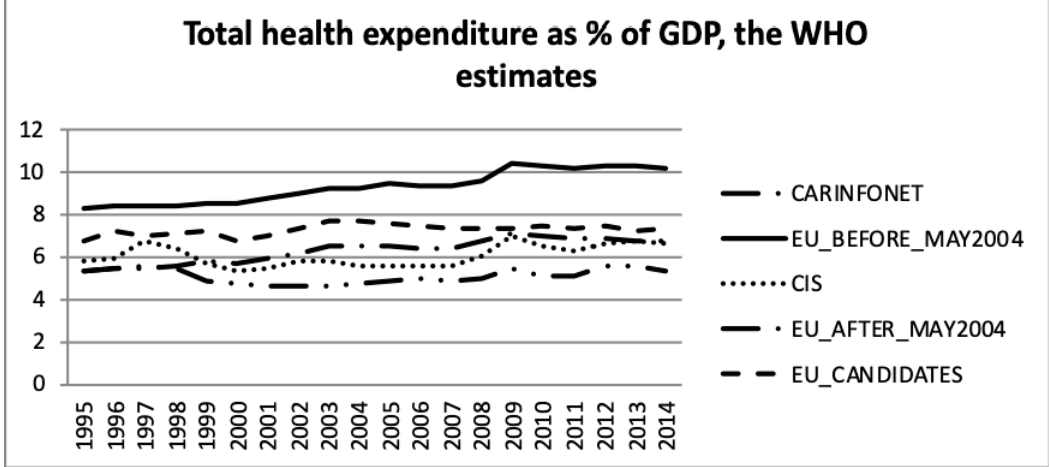
Figure 1. Total health expenditure as a percentage of Gross Domestic Product, the World Health Organization estimates.